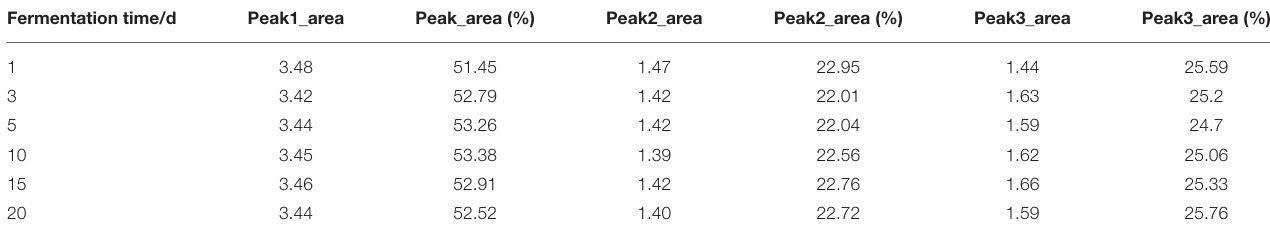
TABLE 6 | Effect of natural fermentation on the chain length distribution of corn ballast starch. Fermentation time/d